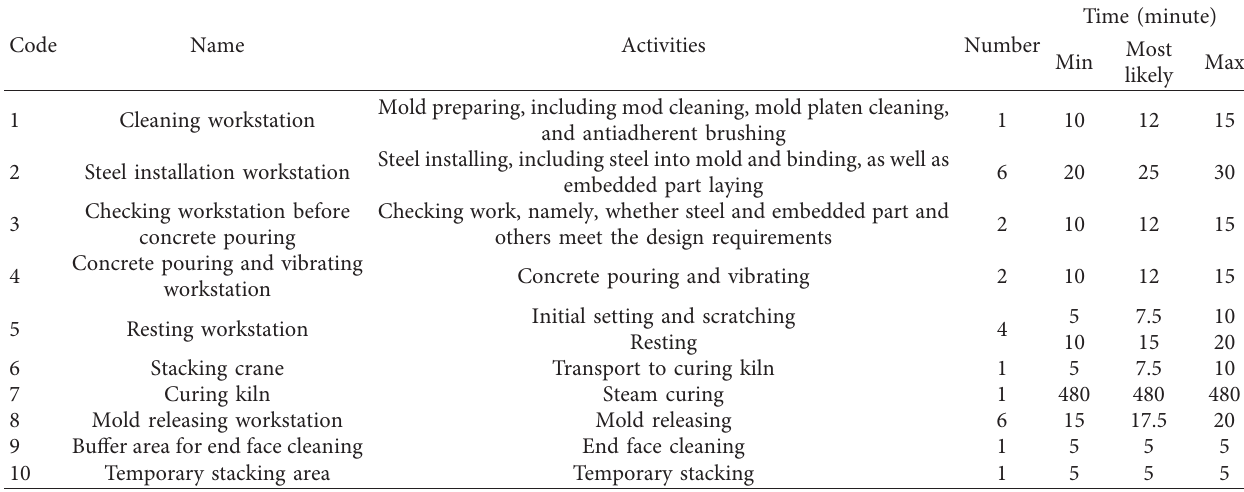
Table 3: Name, activity, number, and time of each workstation used for semiprecast